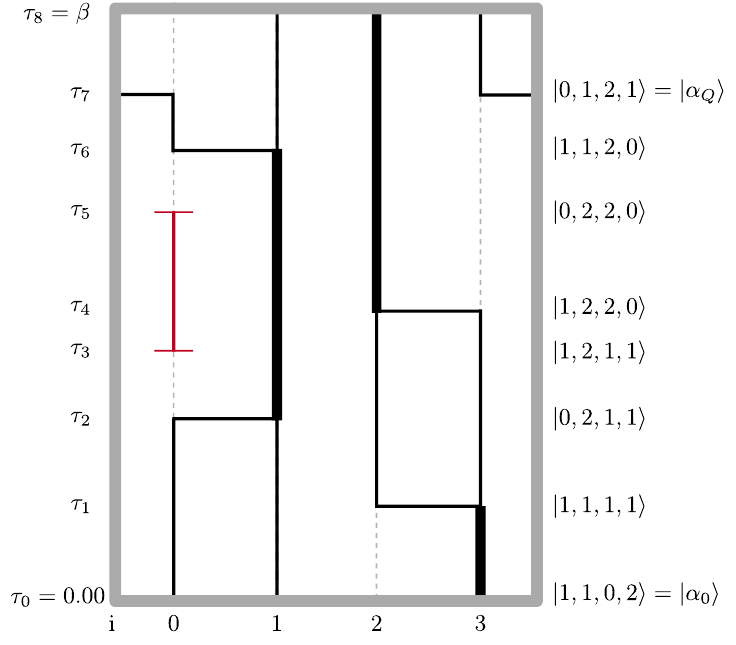
Figure 1: Example of a 4-site worldline configuration. Paths evolve in the direction of imaginary time (vertical axis) and particles can hop between sites (horizontal